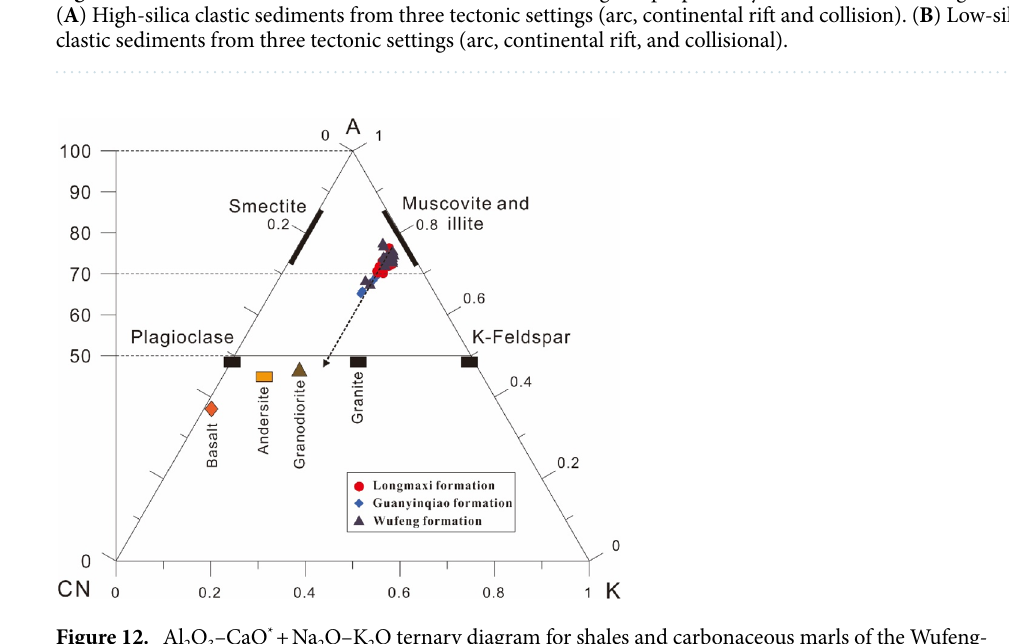
Figure 11. New discriminant function multidimensional diagram proposed by Verma and Armstrong-Altrin 82 .